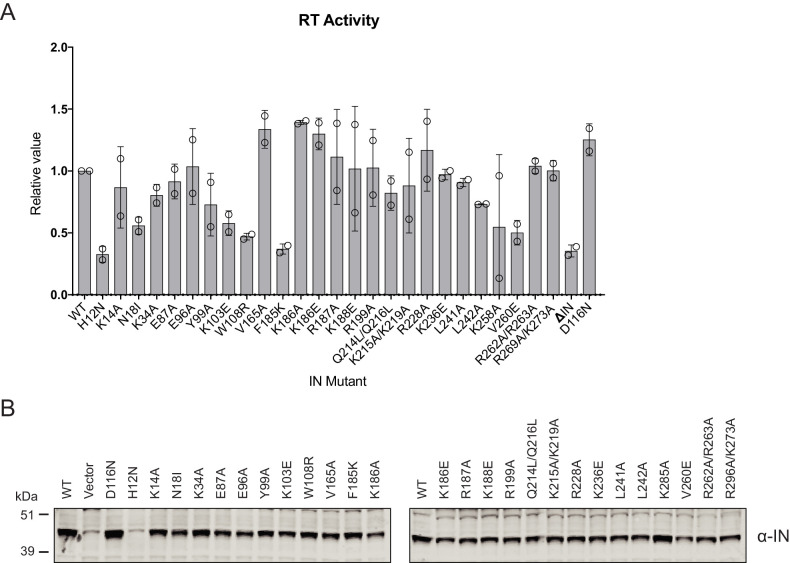
Characterization of the replication defects of class II IN mutant viruses.(A) Reverse-transcriptase activity measured in HIV-1NL4-3 virion lysates. For each repetition RT activities for the IN mutants are expressed relative to the WT (set to 1). Columns show the average of two independent experiments (open circles) and error bars represent standard deviation (****p<0.0001, ***p<0.001, **p<0.01, and *p<0.05, by unpaired t-test between individual mutants and WT). (B) A representative immunoblot analysis of Vpr-IN fusion constructs in cell lysates. HEK293T cells were co-transfected with the HIV-1NL4-3 IND116N proviral plasmid along with Vpr-IN expression plasmids encoding for the indicated IN substitutions or an empty vector control. The expression of Vpr-IN constructs in cell lysates was detected using an anti-IN antibody.